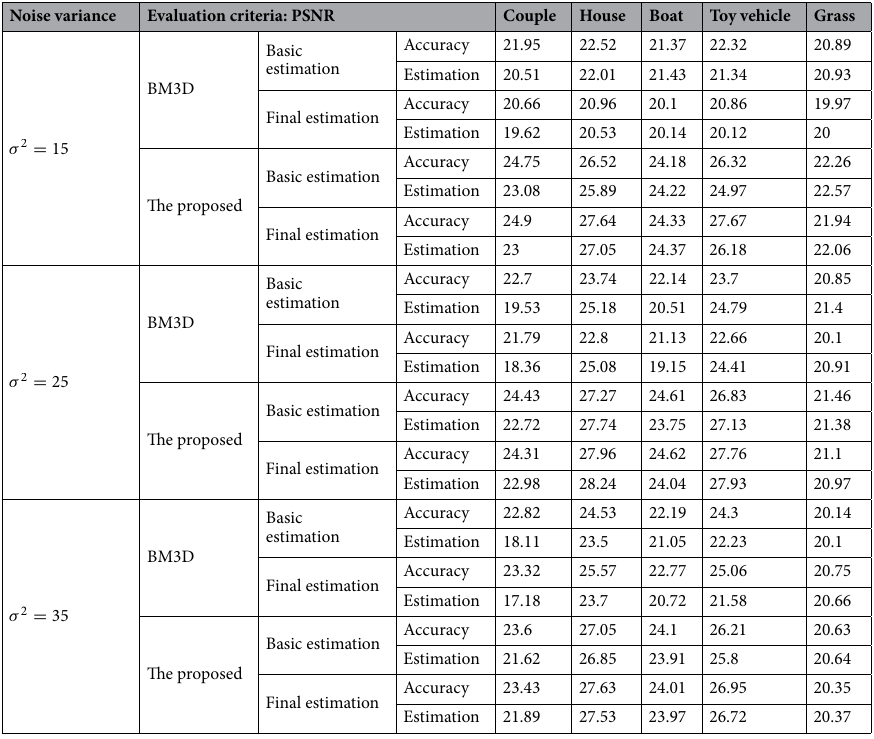
Table 4. The comparison of denoising results between BM3D and the